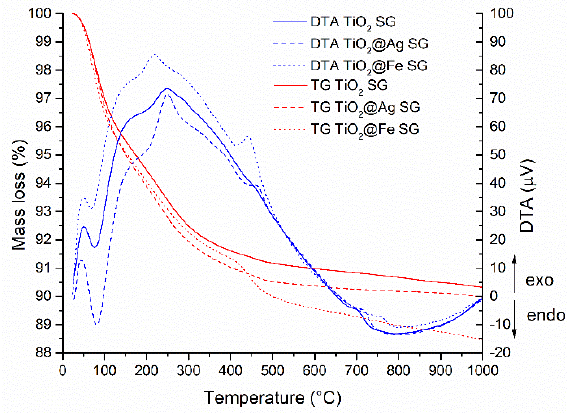
Figure 1. Thermal analysis (DTA and TG) corresponding to the samples obtained by the sol-gel (SG) method.